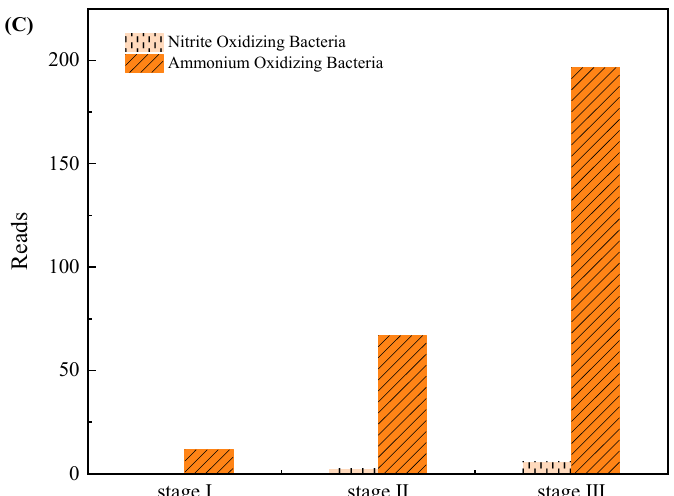
Figure 5. The distribution of bacterial communities in SMBR ( a ) phylum level ( b ) genus level ( c ) Ammonia Oxidizing Bacteria and Nitrite Oxidizing Bacteria.